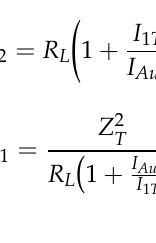
Figure 2. Equivalent circuit of Doherty amplifier ( a ) at low power region and ( b ) at medium and high power region [9].